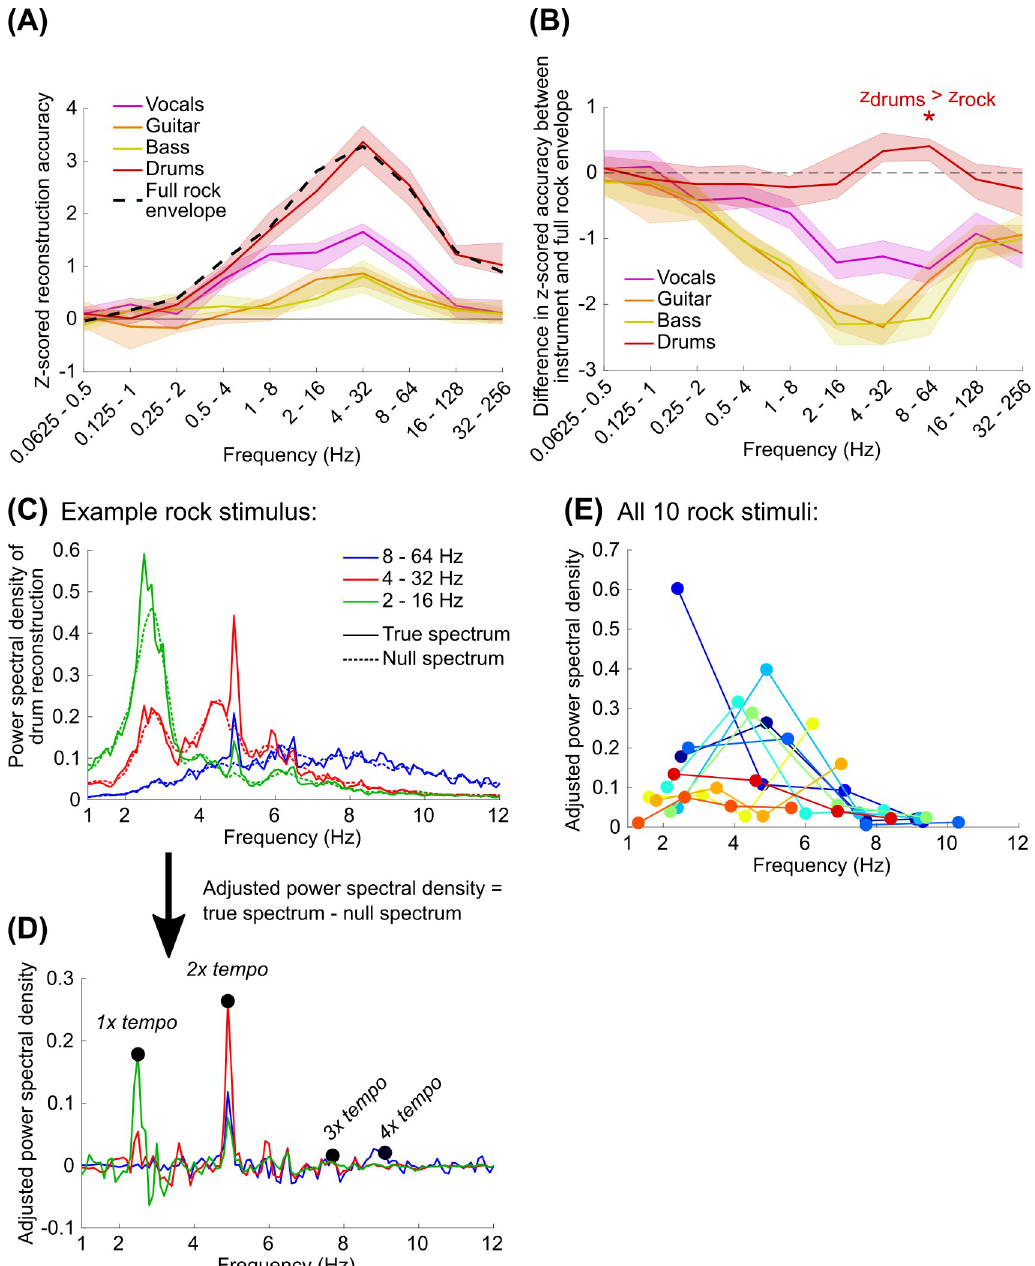
Fig 6. (A) Using the EEG data recorded while subjects were listening to the rock songs, we trained and tested PCA & spline models on the dB envelopes for the vocals, guitar, bass, and drums individually. Z-scored reconstruction accuracies were quantified as in Fig 3A–3D. All instrument envelopes were reconstructed above chance when the model included frequencies above 2 Hz (Wilcoxon signed-rank test: p < 0.001 with Bonferroni correction for 40 comparisons). The full rock envelope, shown with a dashed black line, is equivalent to the values shown in Fig 3D. (B) Pairwise differences between the z-scored reconstruction accuracy for the full envelope and the envelope for each individual instrument. The z-scored reconstruction accuracies for drum were not significantly different than the same pairwise reconstruction accuracies for the rock envelope based on the multi- tracked recording with all instruments, except for the 8–64 Hz model where reconstruction accuracies were slightly but significantly better than full rock envelope (Wilcoxon signed-rank test with Bonferroni correction for 40 comparisons: z = 3.28, p = 0.042). (C) Welch’s power spectral density of the reconstructions was computed for each stimulus and averaged across subjects. The noise floor of the power spectra is shown with dashed lines. (D) We then adjusted the power spectral density by subtracting the true spectrum from the average of the null spectra, which made the peaks associated with temporally